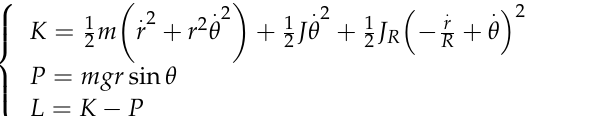
Figure 2. Two-dimensional graphic of a ball and beam system Microsoft Visio ® , Pro 2019 v2005 Build 14026.20302 Retail.